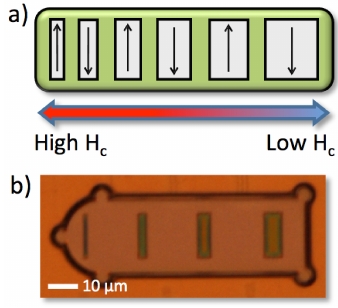
( a ) Illustration of coercivity ( H ) tuned bit encoding, where the varied aspect c ratios of each bit define unique field values at which the magnetisation reversal occurs; ( b ) Microscope image of a four-bit